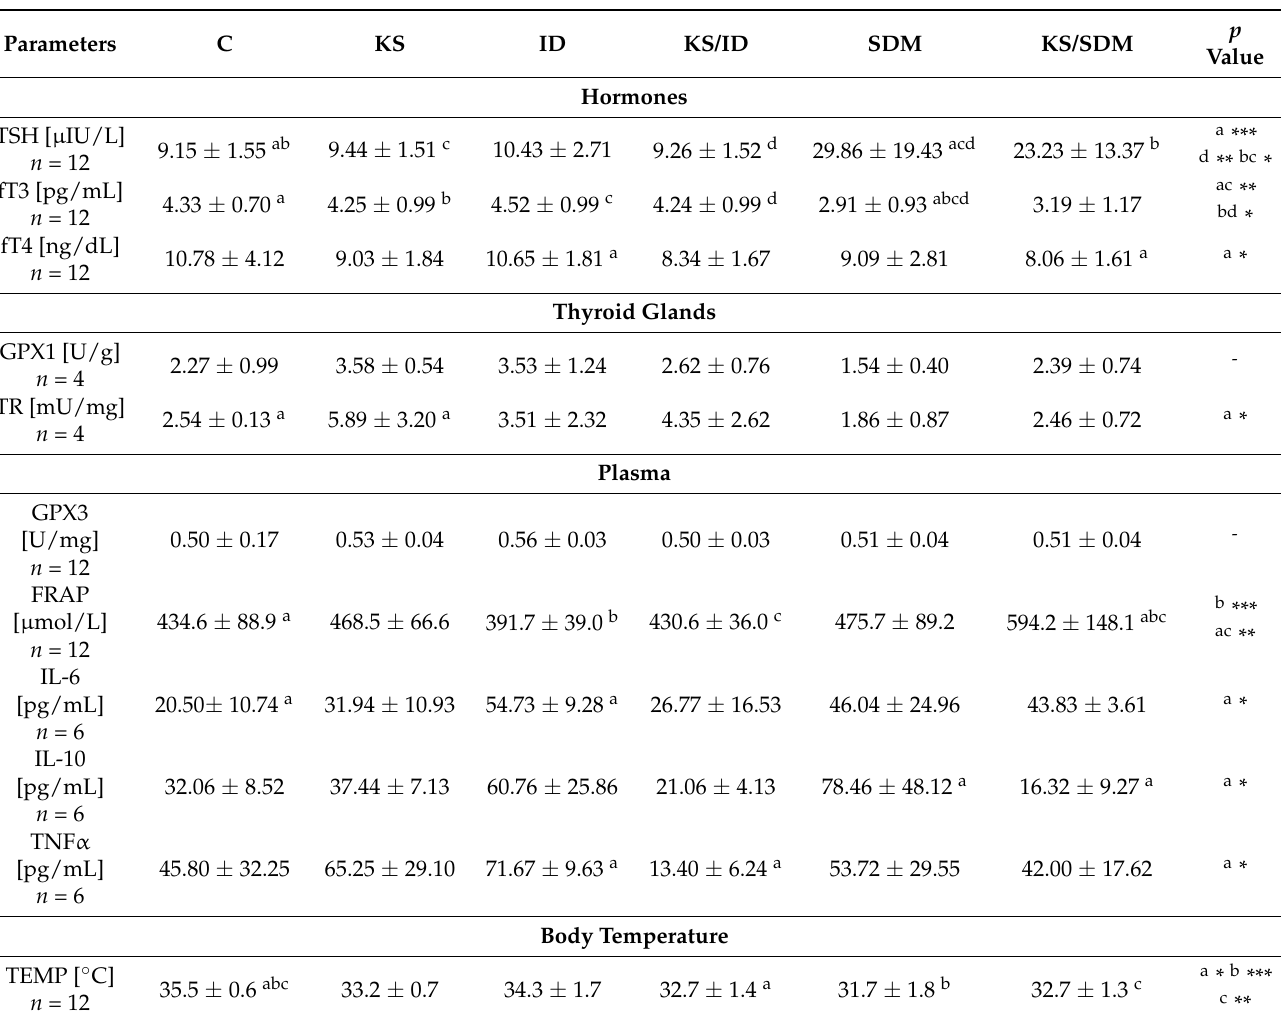
Table 2. Hormone levels, antioxidant status parameters of thyroid glands, plasma level of interleukins, and body temperature of the investigated rats (see Section 2. for the explanation of the groups’ acronyms and all